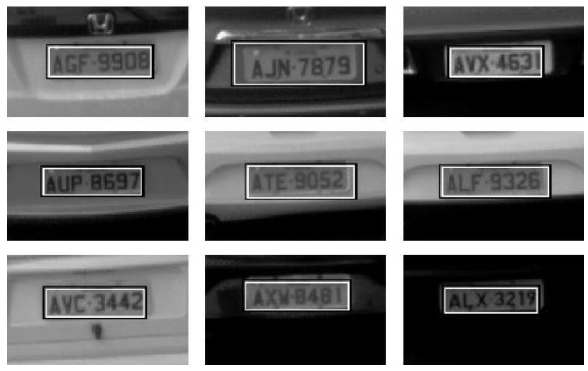
Fig 16 : License plates samples through character detection The speed performance was calculated by comparing the estimated speed, returned by proposed system, with the real speed as shown in Fig. 17. The average error, for the complete dataset, was 0 . 59 km/h and a standard deviation of 1 . 63 km/h.